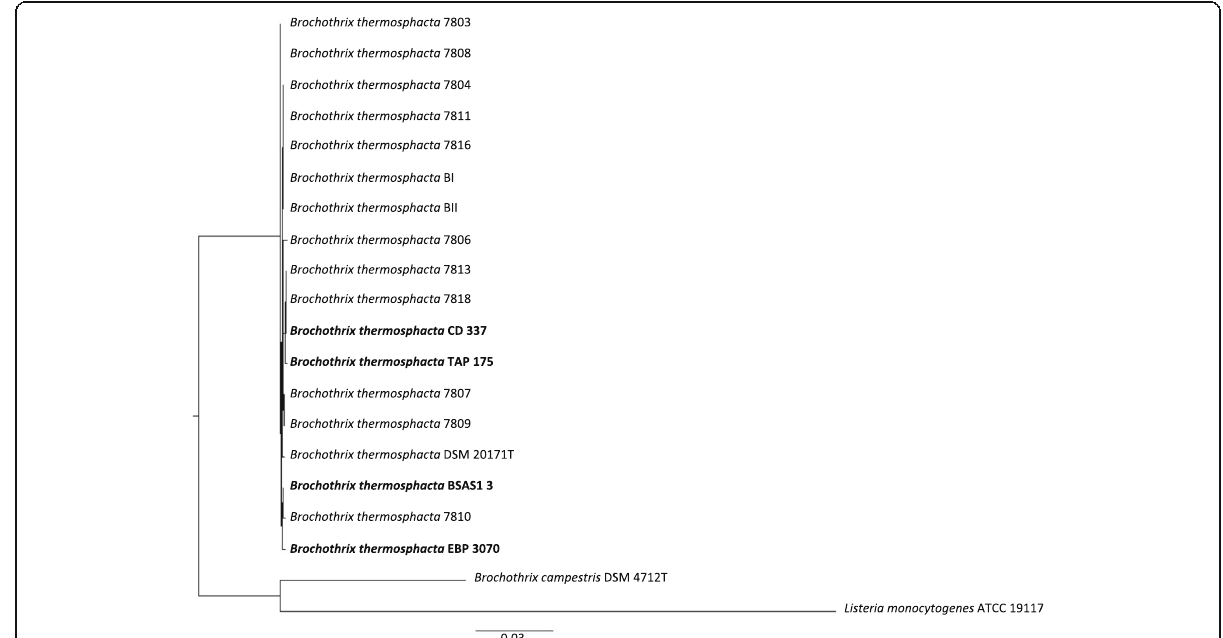
Fig. 1 Phylogenetic tree showing the relationship of the four Brochothrix thermosphacta strains (shown in bold print) to other B. thermosphacta strains the genome of which is publically available. Brochothrix campestris , and Listeria monocytogenes type strains were used as outgroup. Tree is based on MAFFT (v7.309) [42] aligned complete rpoB gene sequences. The tree was built using FastTree (v2.1.5) then visualized with FigTree